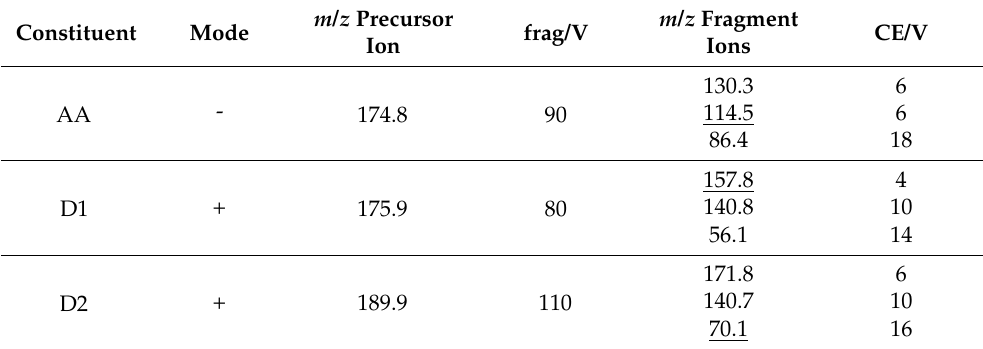
Table 2. MRM parameters for MS/MS analysis. The table lists the recording mode (mode), m / z precursor ion, fragmentor (frag), m / z fragment ions and collision energies (CE) for AA, NH 2 AA (D1), and CH 3 NHAA